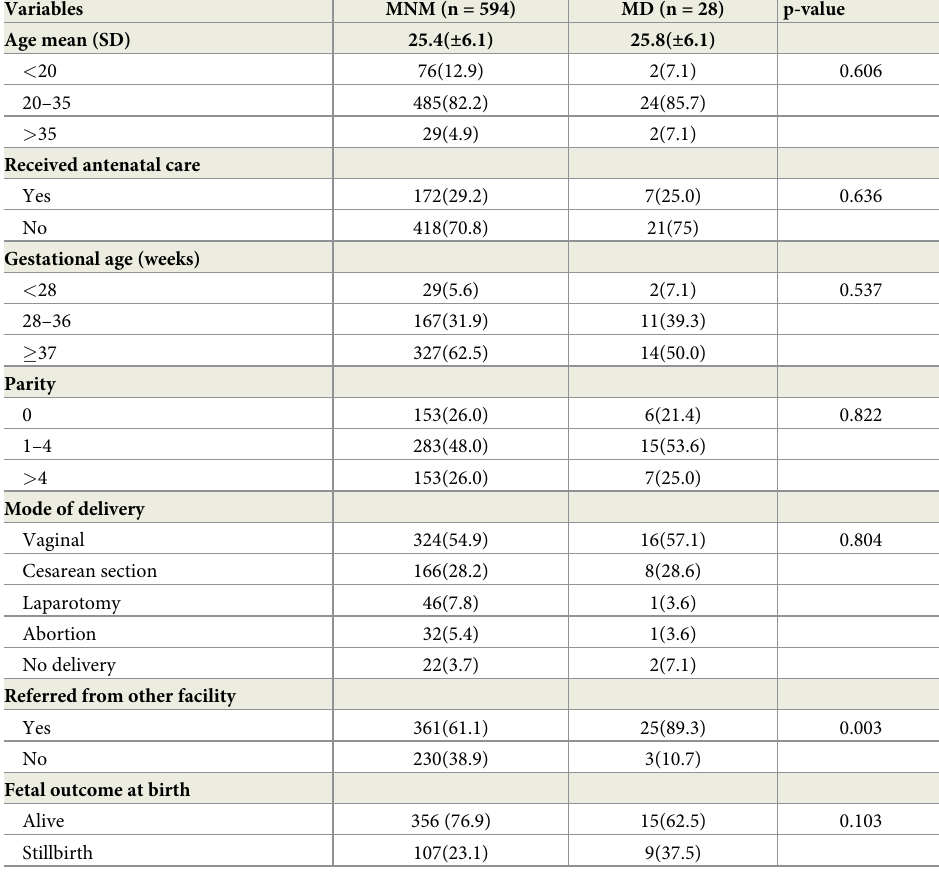
Table 2. Sociodemographic and obstetric characteristics of MNM and deaths in eastern